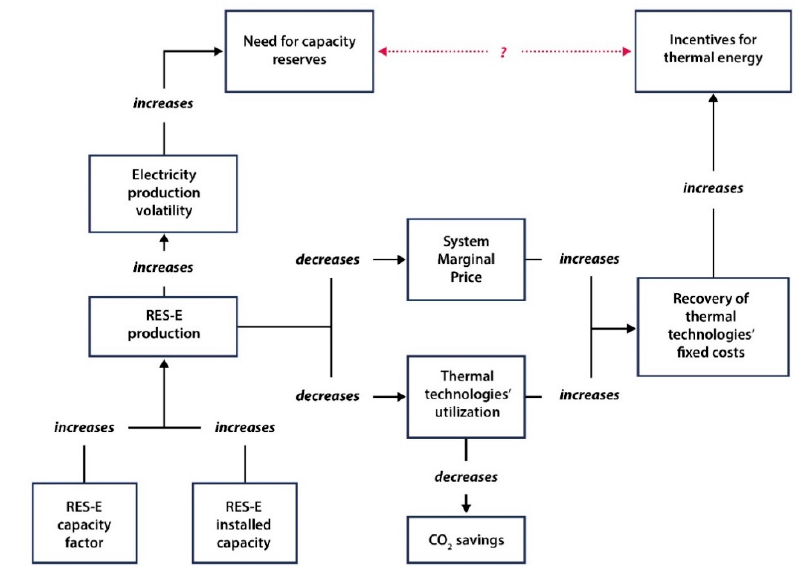
Figure 1. Influence of electricity generation from RES (RES-E) growth on different aspects of the electricity system over the past few years.